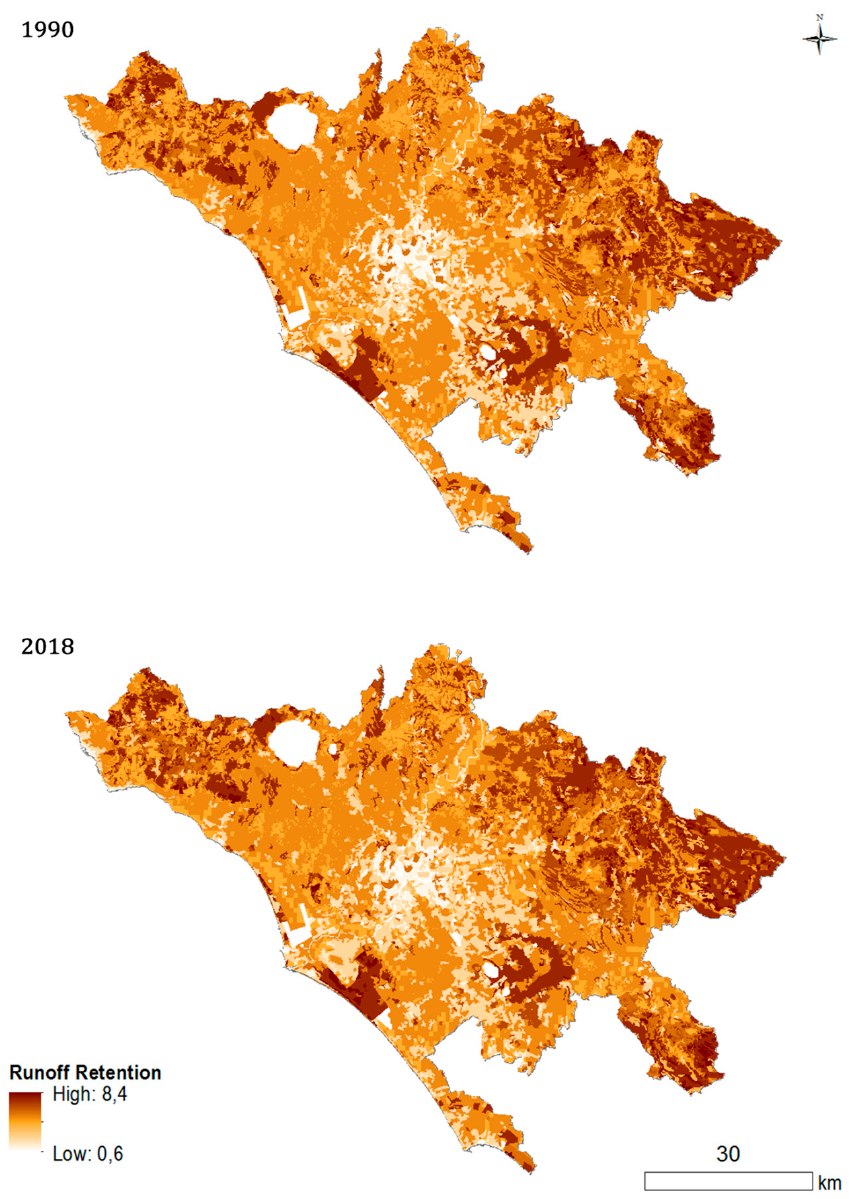
Figure A2. Runoff retention in 1990 and Figure 2. Runoff retention in 1990 and 2018.